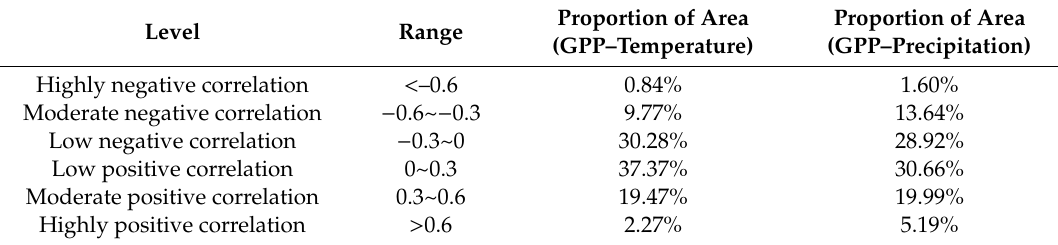
Table 2. Area statistic of the correlations between annual mean BESS GPP and the corresponding temperature and precipitation in China from 2001 to